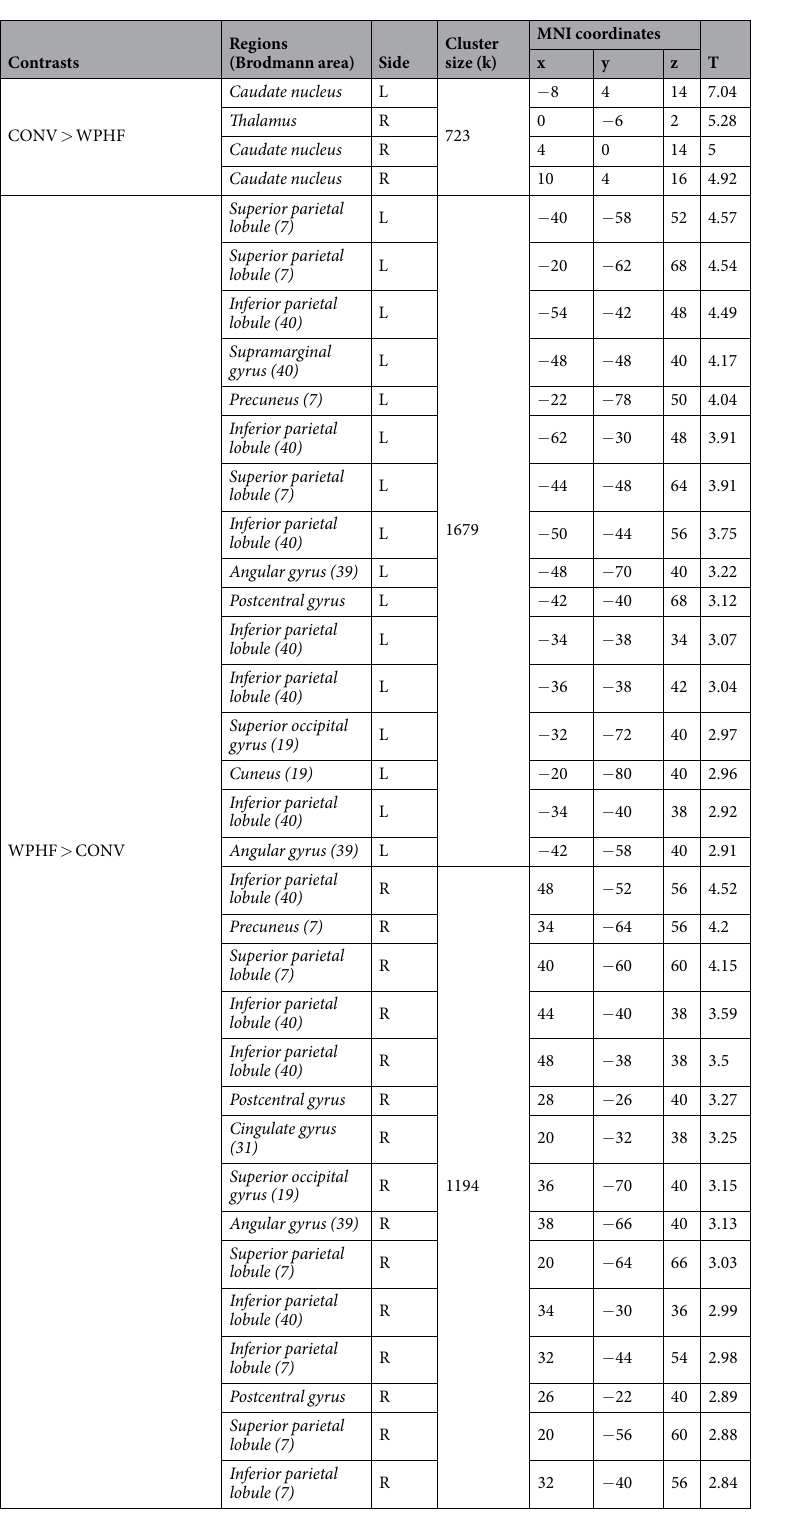
Table 2. Differences in brain activation between the two NMES protocols ( p < 0.005; k = 20; FDR corrected at cluster level p <